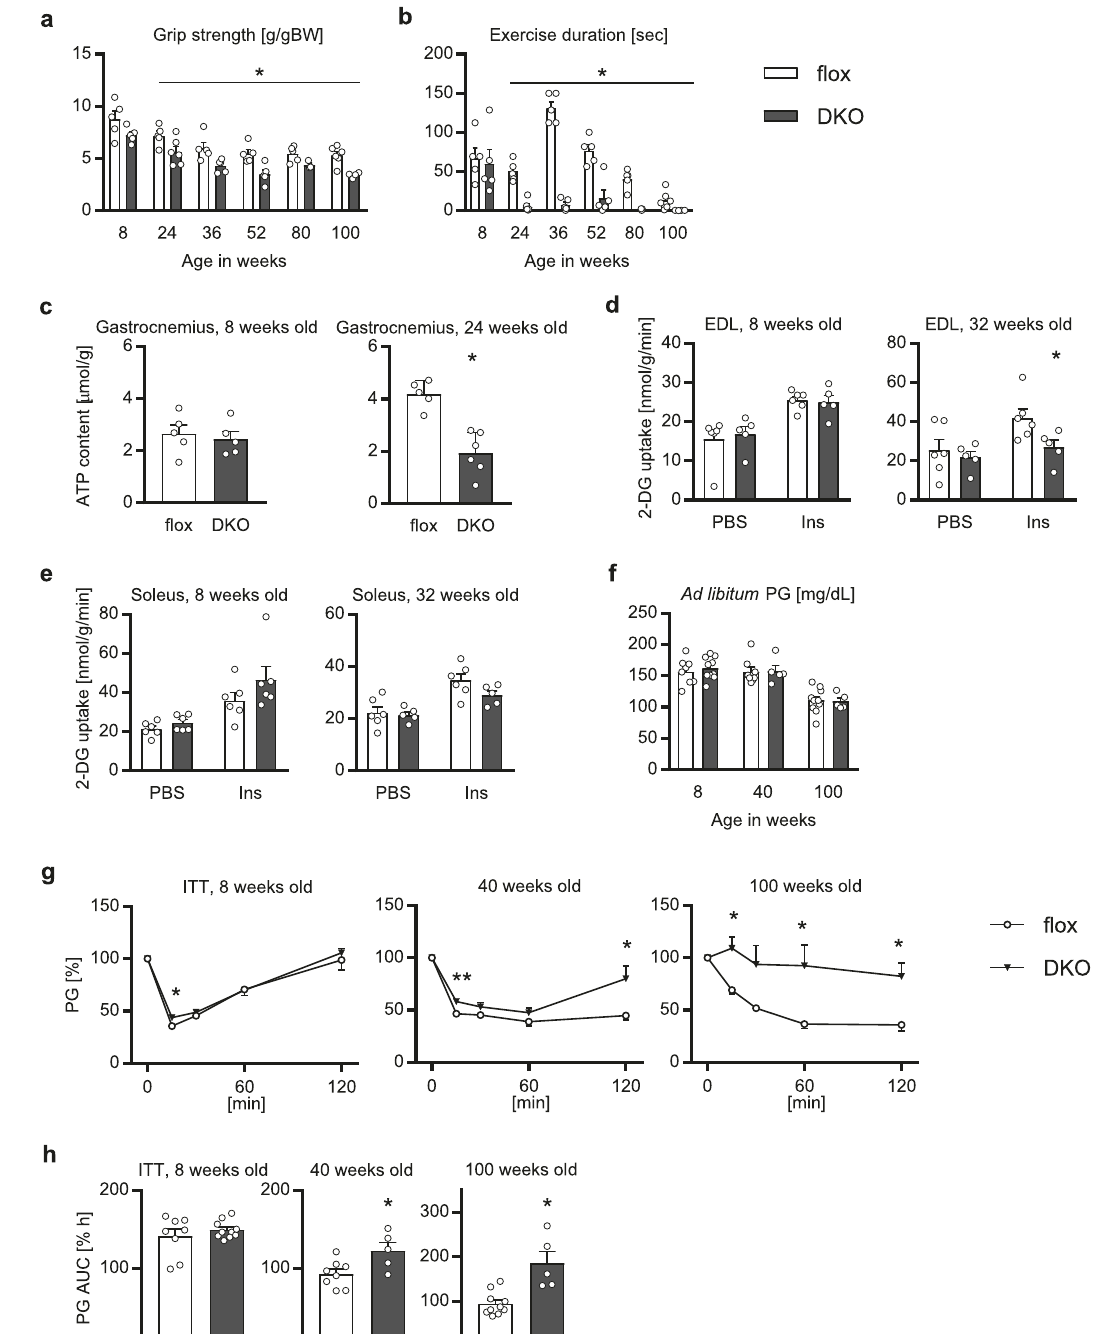
Fig. 3 | Skeletal muscle-associated phenotypes of the mAktDKO mice. a Grip strength and b exercise duration, of the mAktDKO mice atthe age of the indicated weeks( n =3,4,5or6micepergroup,asshownbythenumberofdatapointsonthe graph, same as below). c ATP contents of gastrocnemius after exercise for 60minutesattheageof8weeks( n =5mice)andafterexercisefor15minutesatthe age of 24 weeks ( n =5 or 6 mice). d , e Insulin-dependent glucose uptake in, d EDL and e soleus,analyzedexvivousing2-DGattheageoftheindicatedweeks( n =5or 6 mice). f – h Ad libitum plasma glucose (PG) before insulin challenge ( f ), g relative